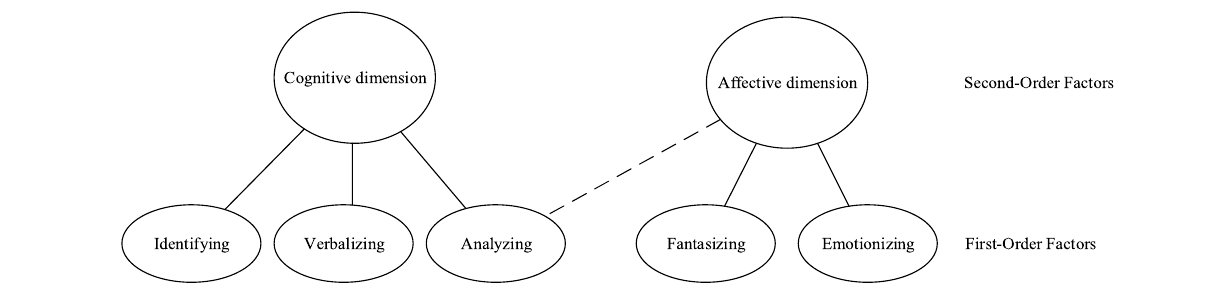
FigUre 2 | Second-order factor structure of the Bermond–Vorst Alexithymia Questionnaire based on exploratory factor analyses on the indicative items and on the counter-indicative items (analysis sample).